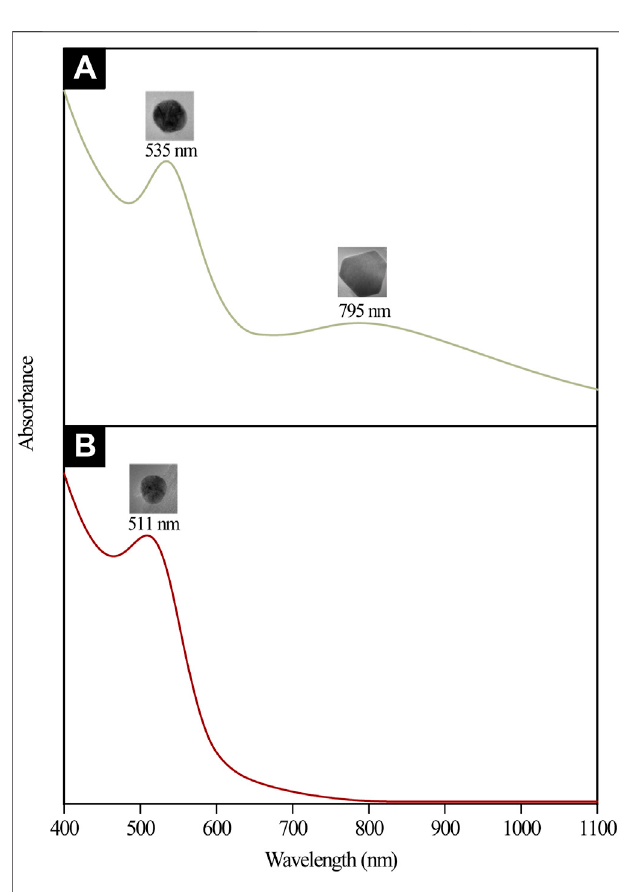
FIGURE8 | UV-Vis-NIRabsorption spectra and the corresponding TEM micrographs of (A) anisotropic AuNPs@pH6 and (B) isotropic AuNPs@pH10